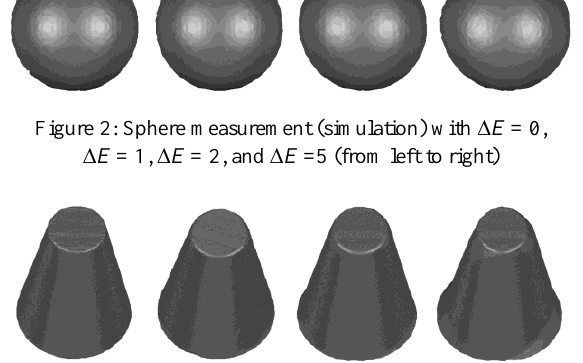
Figure 3: Simulated frustum of a cone measurement with  E = 0,  E = 1,  E = 2, and  E = 5 (from left to right)